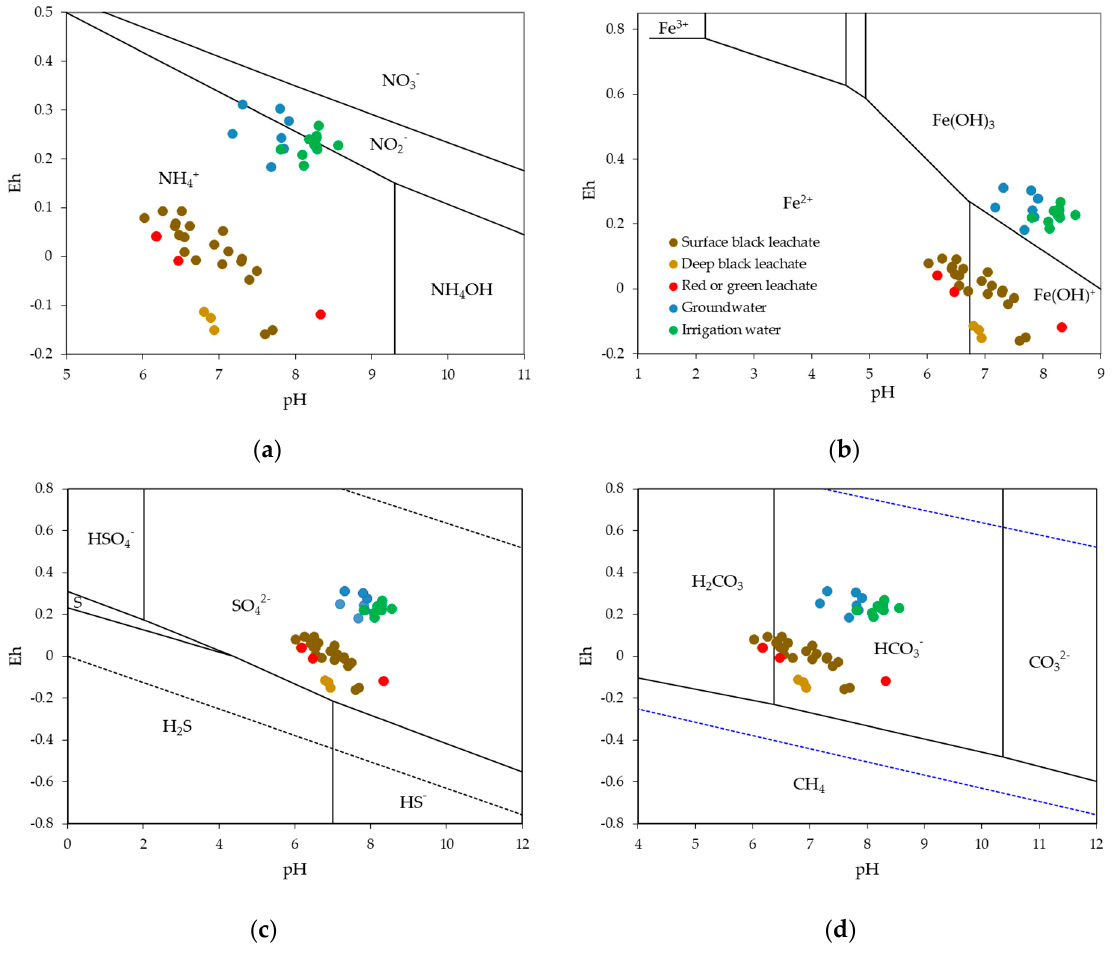
Figure 4. Pourbaix diagram showing the species stability domains for irrigation water, ground water and leachates for ( a ) N, ( b ) Fe, ( c ) S, and ( d ) C.